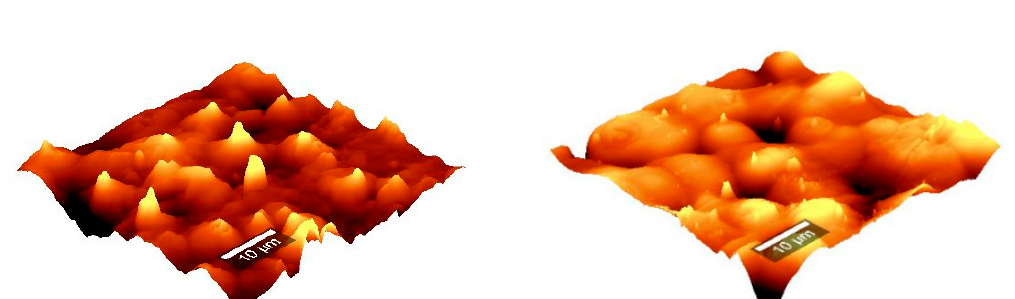
Table 6. Scanning electron microscopy (SEM) pictures of PHBV films blended with triethyl citrate (TEC).